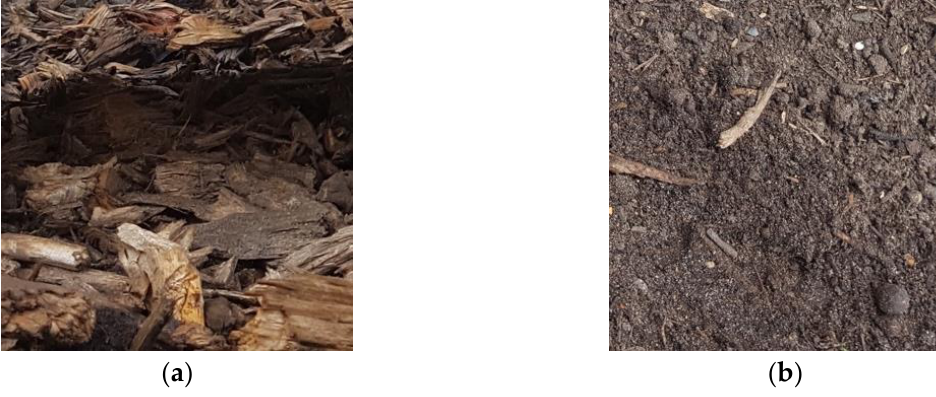
Figure 3. Applied filling materials, ( a ) A mix of stumpwood chips and pine bark (CB), ( b ) a mix of stumpwood chips, pine bark, and green waste compost (CBC).